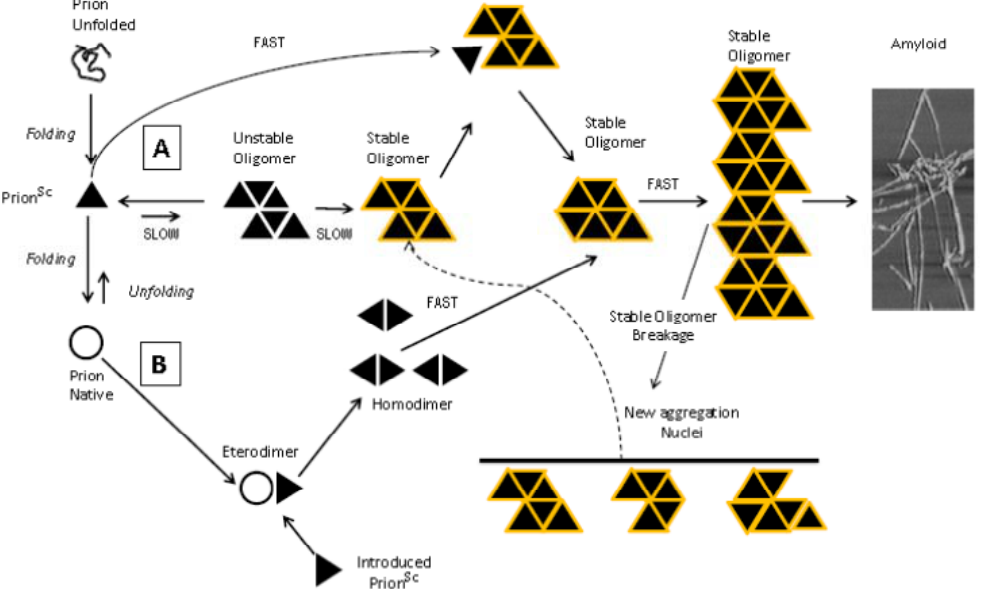
Figure 1. Schematic representation of the proposed mechanisms of PrP C conversion into PrP Sc and aggregation in amyloid fibrils. To date, two main mechanisms have been proposed to explain the auto-propagation of PrP Sc from newly synthesized PrP C and the final aggregation in amyloid fibrils: nucleation-polymerization ( A ) and template assisted ( B ) models. In the nucleation-polymerization model, the correct folding of newly synthesized prion peptide proceeds through distinct intermediates. Some of them are able to self-associate to form non-native oligomeric species of different sizes and structures. In the presence of stable oligomeric aggregates (illustrated by the collection of orange PrP seed triangles), a change from PrP C to PrP Sc is favored ( A ). In the template-assisted model ( B ), the interaction between exogenously introduced (or stochastically generated) PrP Sc with endogenous PrP C , induces the conversion of PrP C in PrP Sc , generating stable oligomeric aggregate. Independently from the model proposed, the growth of the stable nuclei is unlimited, generating macro-aggregate and amyloid